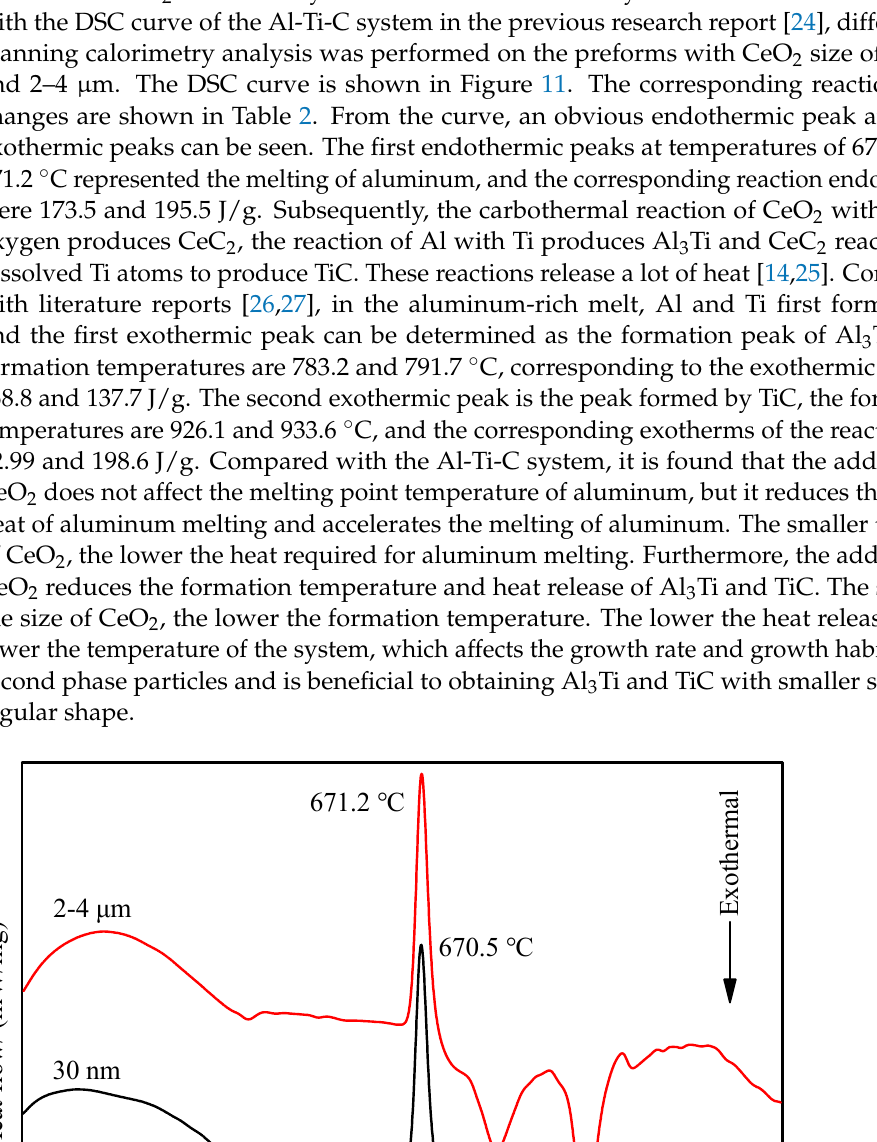
µ 2 size of: 30 nm and 2–4